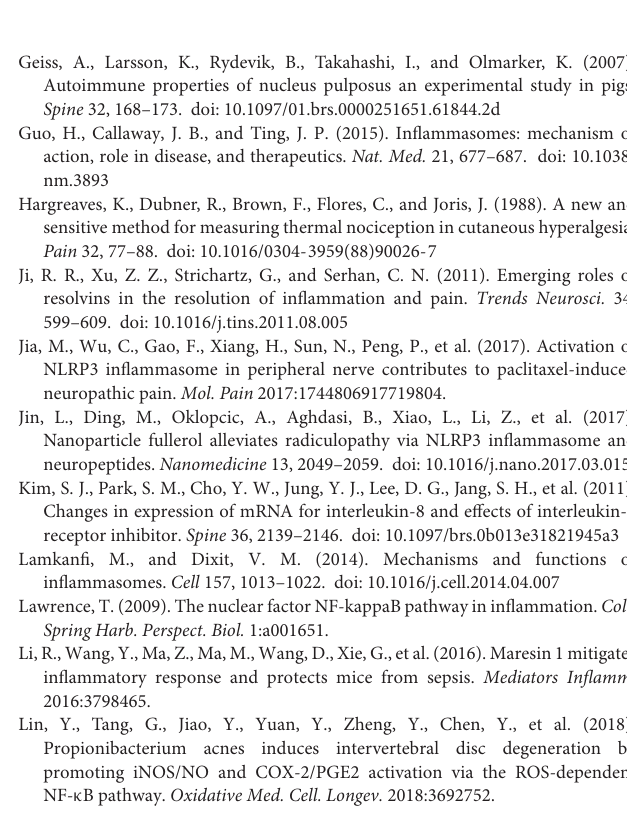
FIGURE S1 | Assessment of pain behavior in contralateral side and sham groups with MaR1 ( n = 8/group). (A,B) The contralateral PWL and PWTs didn’t show any differences among the four groups. (C,D) The PWL and PWTs were not different in the sham rats with or without MaR1 treatment. Data are presented as the mean ± SD. FIGURE S2 | Comparison of the stability of β -action and GAPDH mRNA expression in spinal dorsal horns ( n = 5/group). The stability of β -actin expression was confirmed in spinal dorsal horns under several different treatments by comparison of Ct values of β -action and